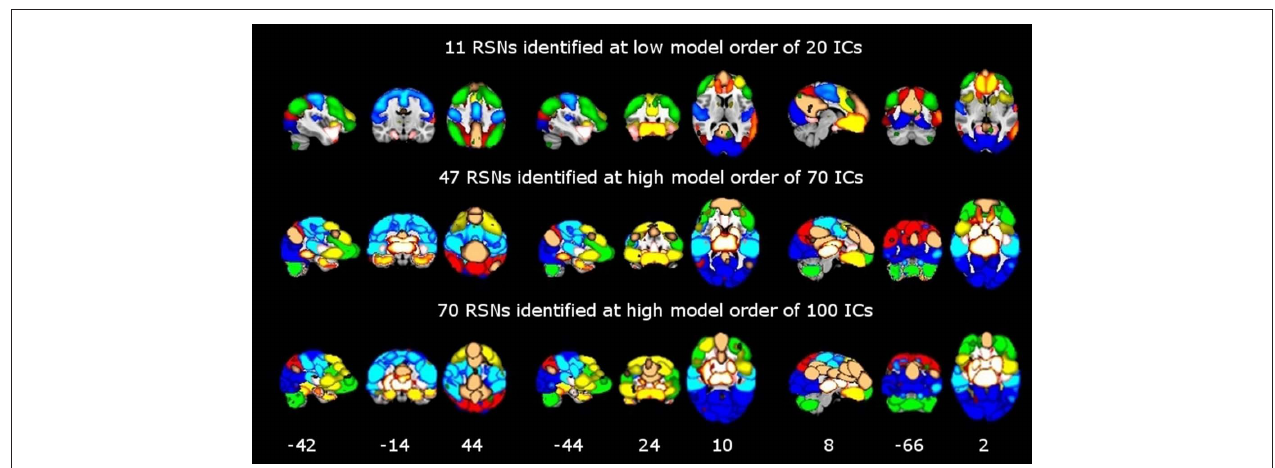
model order 70 (middle) and 100 (bottom), respectively. The same color templates (Fslview color templates) were used to mark the fine-clustered and large-scale RSNs. Numbers at the bottom of the images refer to MNI